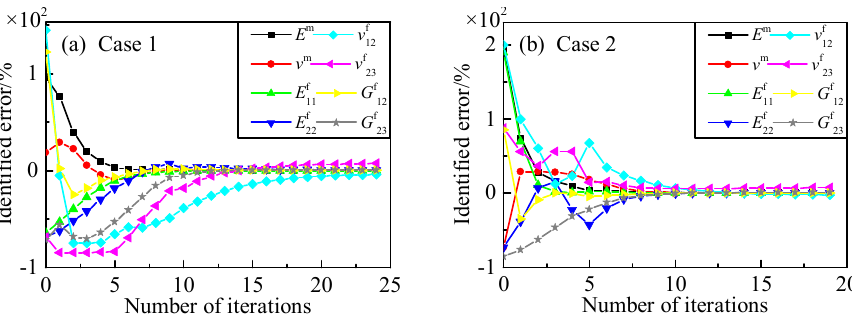
Figure 7. Identified process for constituent parameters with six points (the finite difference method).